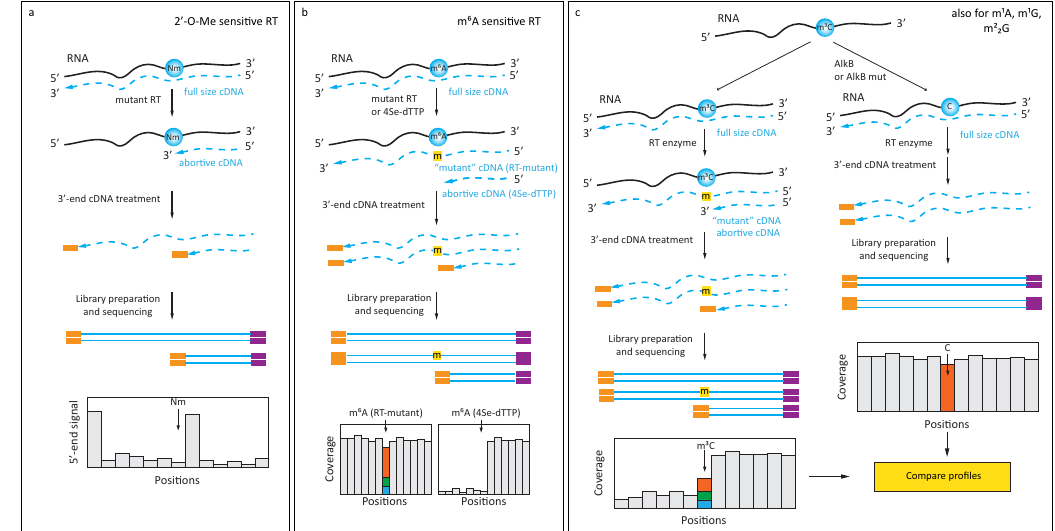
Figure 1. Detection of 2 (cid:48) -O-methylation, m 6 A and AlkB-sensitive modifications in RNA ( a ) Engineered polymerase arrests reverse transcription at 2 (cid:48) -O-methylated residue at normal [dNTP]; ( b ) Ab-independent detection of m 6 A residue using an engineered polymerase or a 4-Se derivative of dTTP (4Se-dTTP). The presence of an m 6 A residue in the RNA template is reflected by a misincorporation signature in the cDNA; ( c ) Improved confidence in the detection of AlkB-sensitive RNA modifications (m 3 C, m 1 A, m 1 G, and m 2 2 G) comes from comparison of RT-signatures (including misincorporation and RT-arrest) before and after AlkB